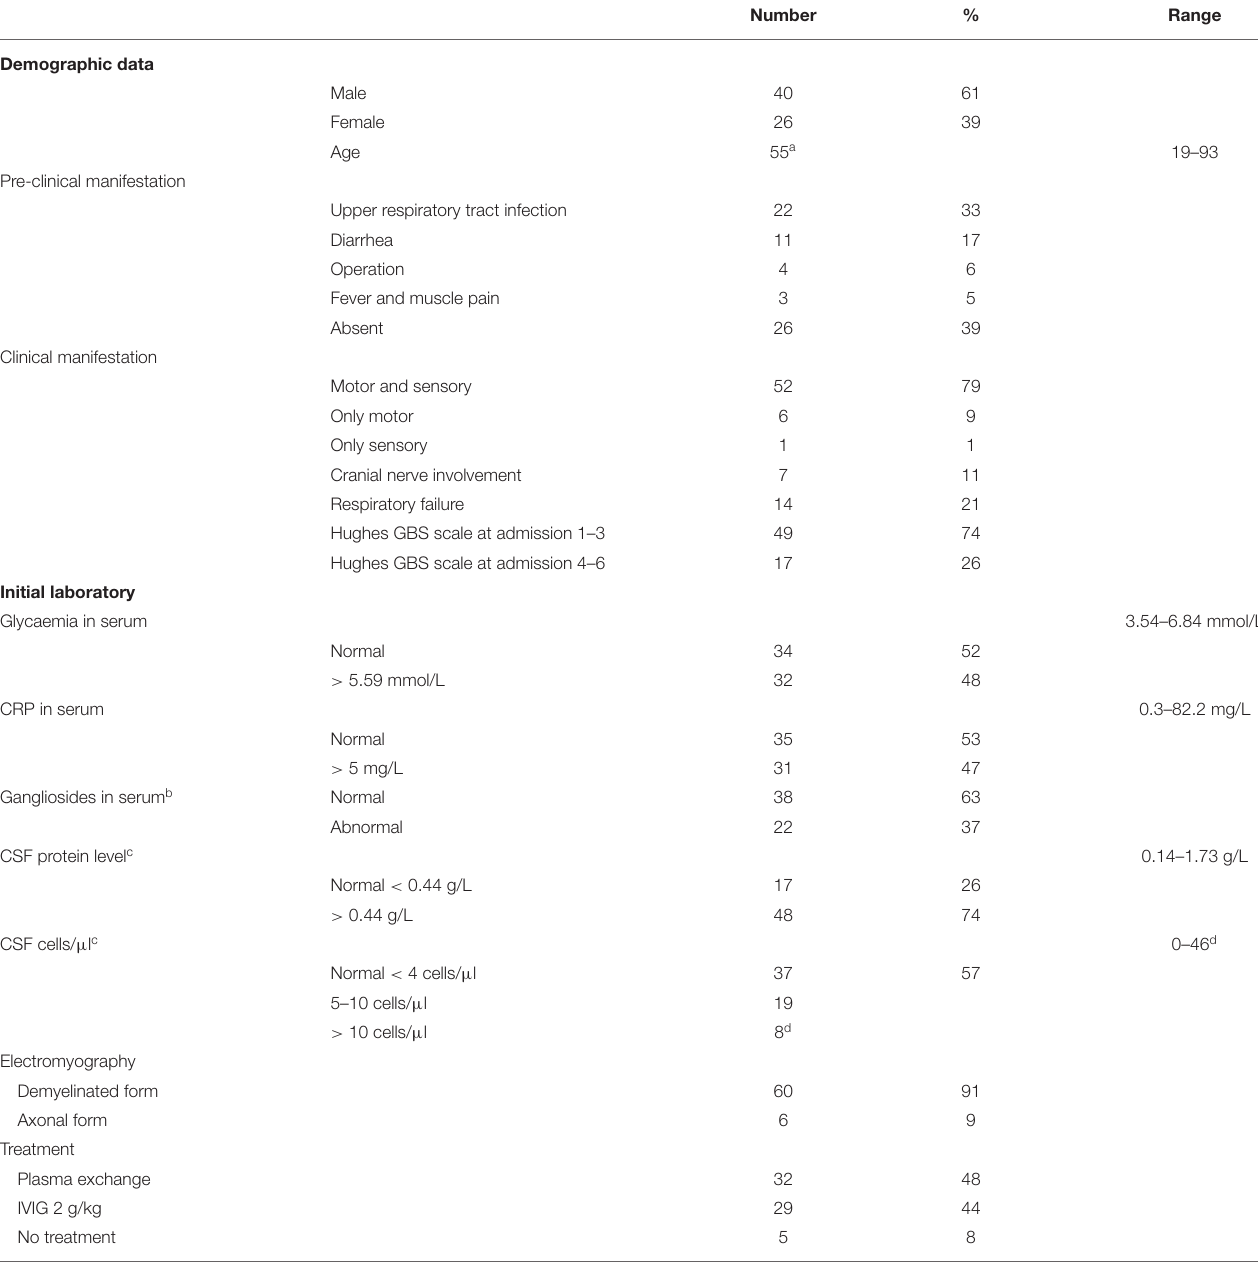
TABLE 1 | Demographic, clinical, laboratory and treatment data in patients with Guillain-Barré